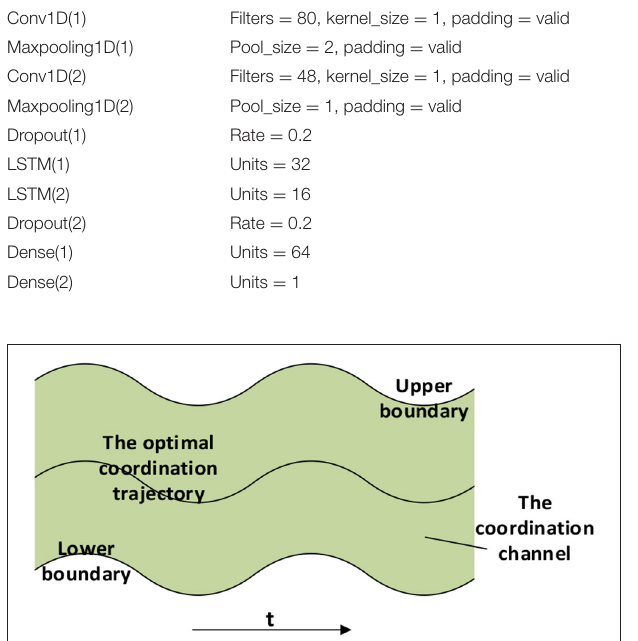
FIGURE 6 | The optimal coordination trajectory and the virtual channel for the robot control ensure the motivation and coordination of patients.